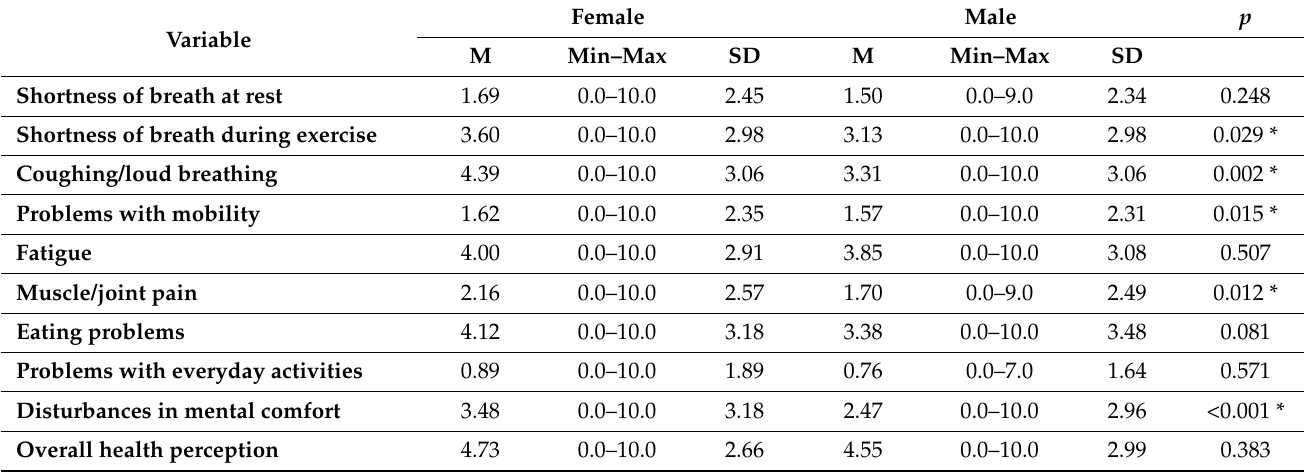
Table 5. Relationship between gender and complications after COVID-19.